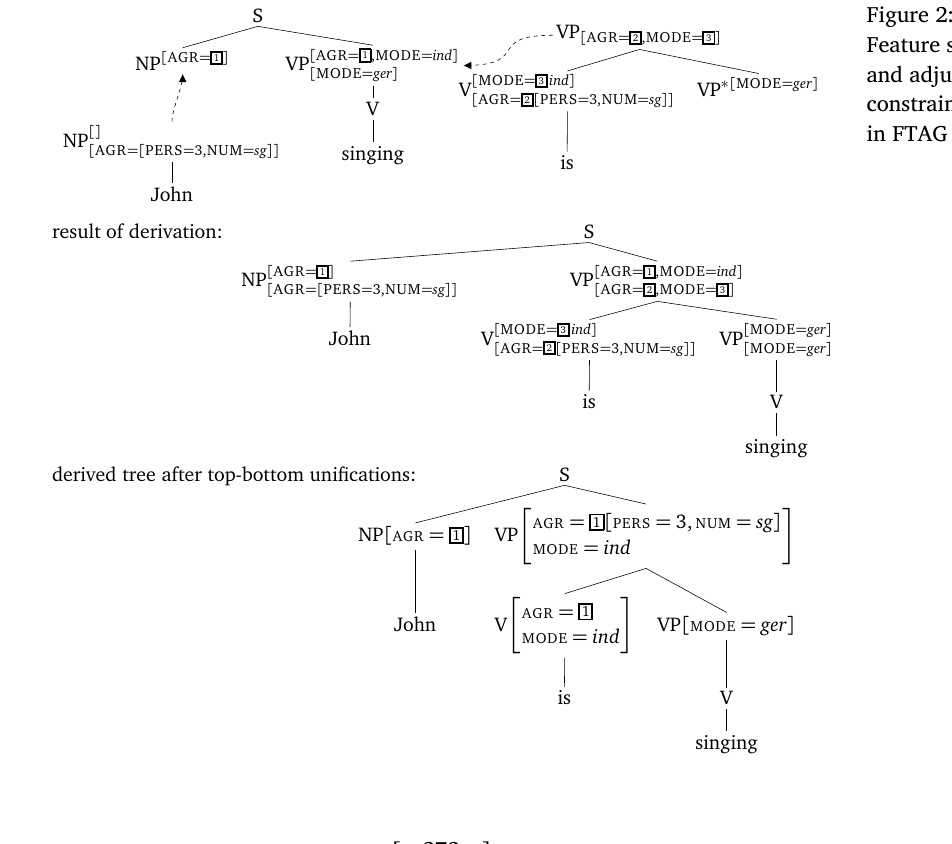
Feature sharing and adjunction constraints in